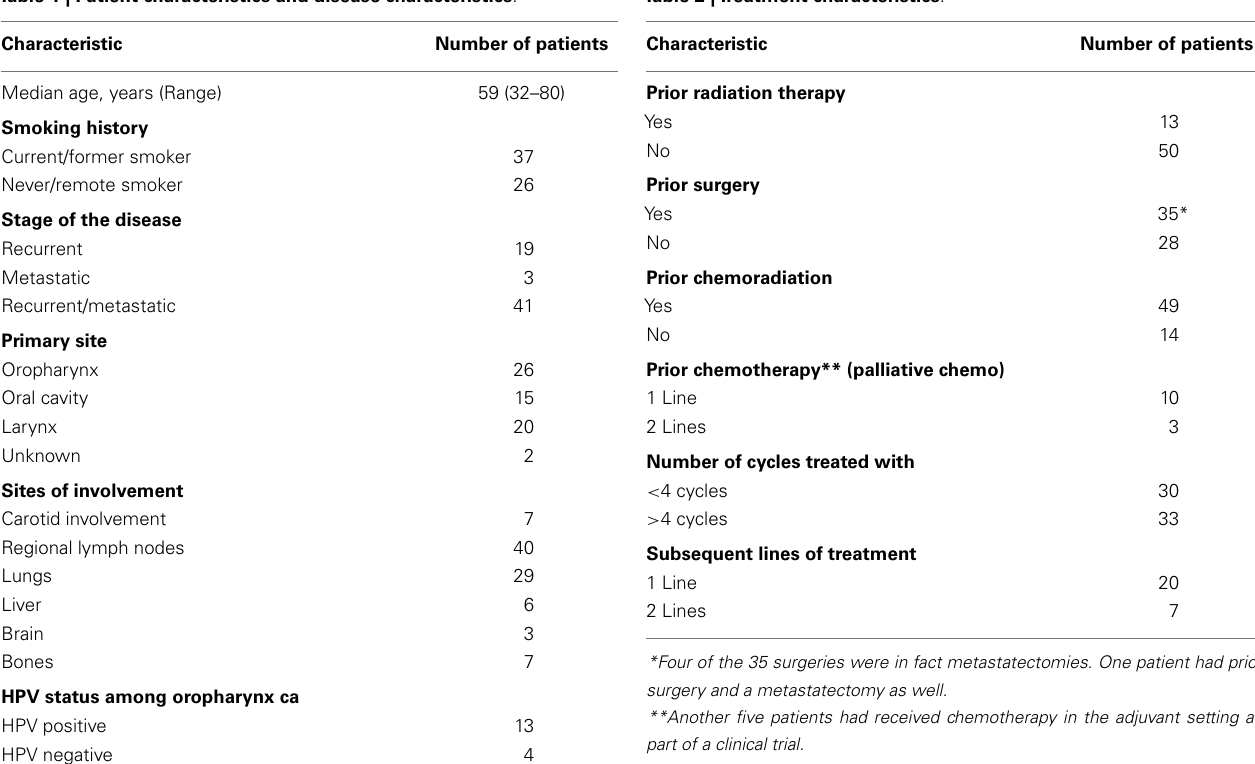
Table 1 | Patient characteristics and disease characteristics . Table 2 |Treatment characteristics